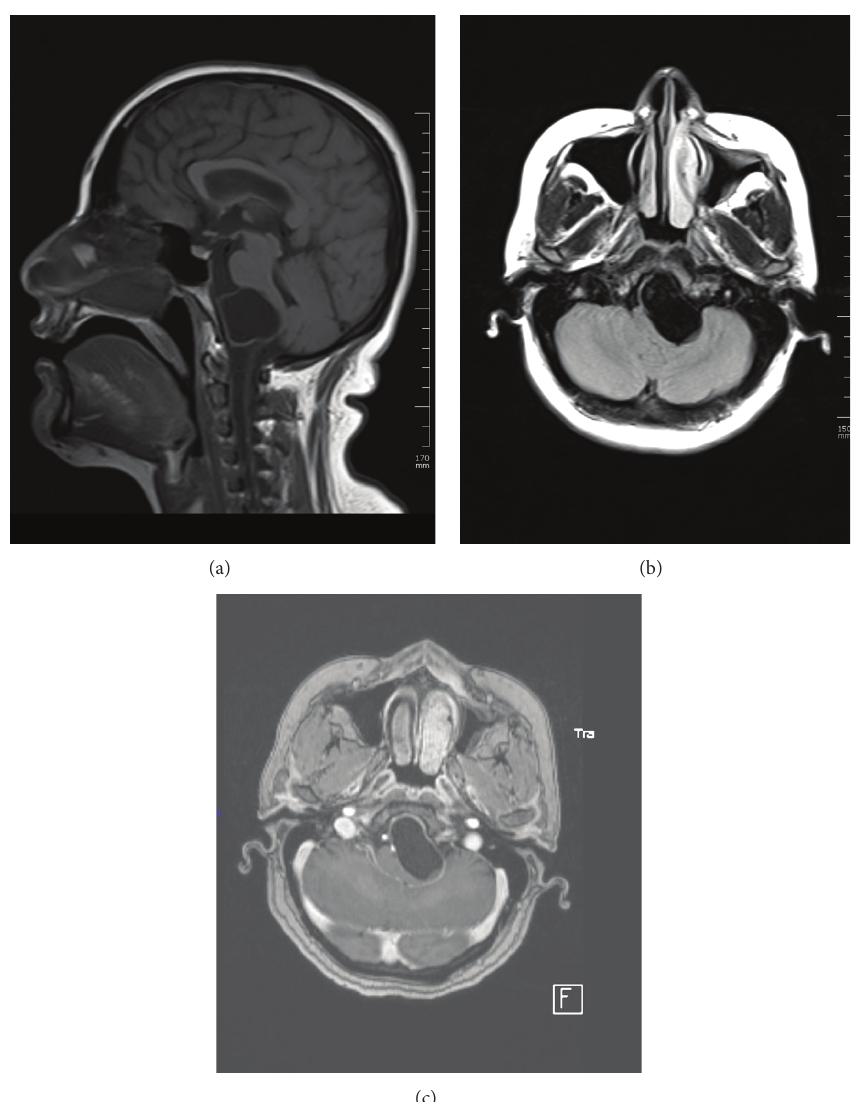
Figure 1: (a) T1W sagittal, (b) FLAIR transverse, and (c) postcontrast T1W transverse images. An unhanced cystic mass is seen in the premedullary space. The slightly left parasagittally located mass is compressing the brainstem left